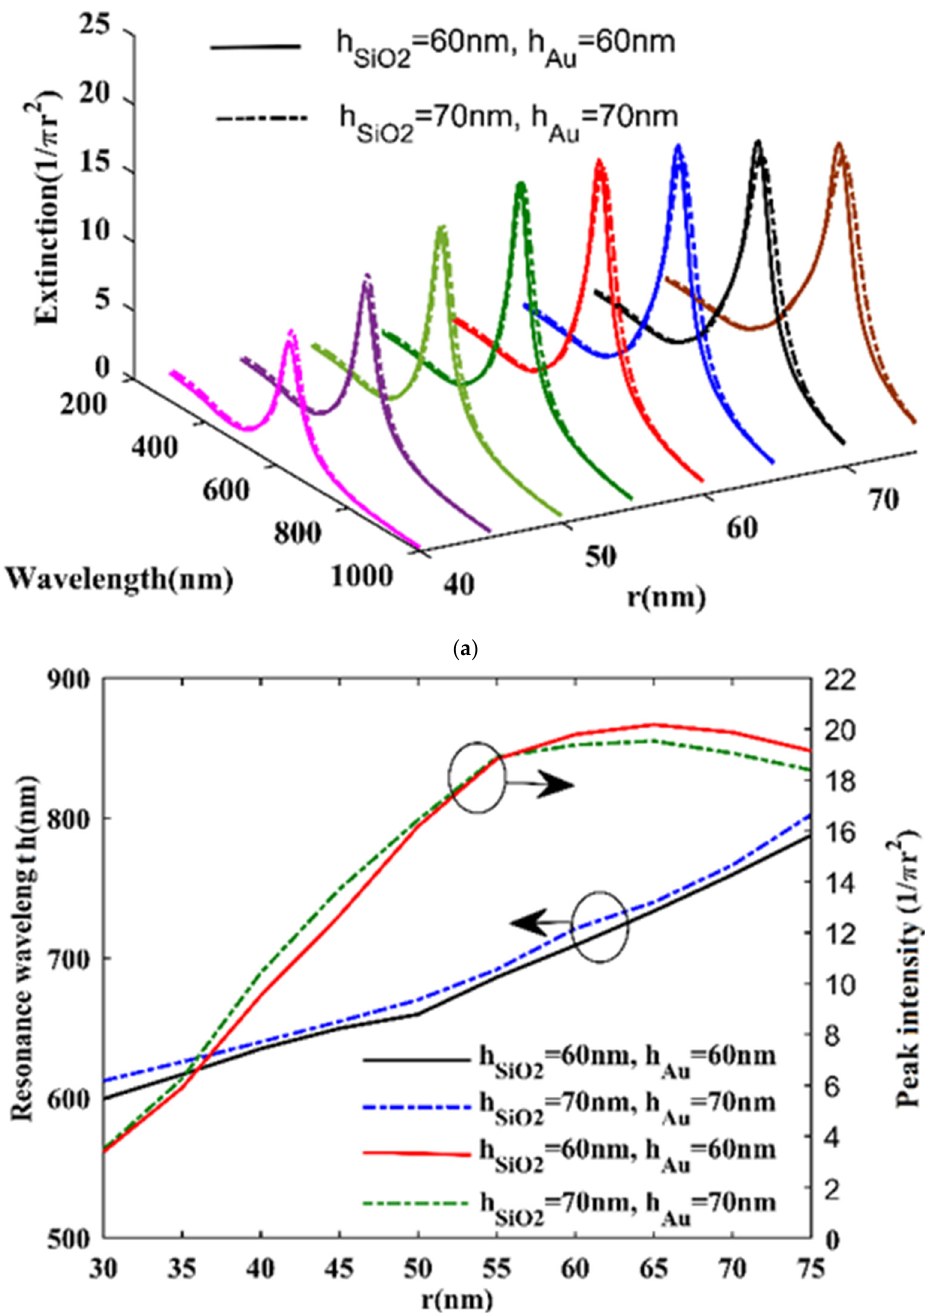
Figure 5. Extinction, resonance wavelength and peak intensity of MIM nanocylinders: ( a ) 60 nm/60 nm/60 nm and ( b ) 70 nm/70 nm/70 nm Au/SiO 2 /Au thicknesses.